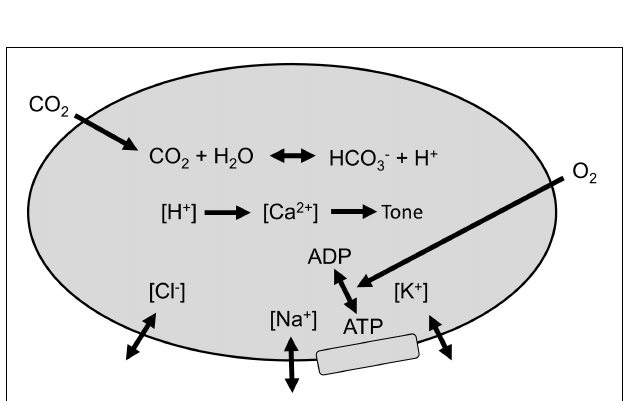
FIGURE 1 | Regulation of smooth muscle [H + ]. Membrane ion exchangers control strongly dissociated ions, and arterial CO 2 determines intracellular PCO 2 . Intracellular [H + ] determines [Ca 2 + ] and vascular smooth muscle tone, which controls cerebral blood flow (CBF). O2 is required to fuel the energetic process of controlling